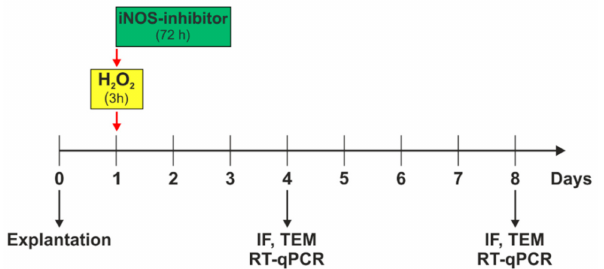
Figure 1. Experimental setup. Porcine retinas were cultivated for four and eight days. Oxidative stress was induced by 300 µ M H 2 O 2 on day one, for three hours. Simultaneously to the stressor, the iNOS-inhibitor treatment was applied and remained on retinal explants for 72 h. On day four, immunofluorescence (IF), transmission electron microscopy (TEM), and quantitative real-time PCR (RT-qPCR) analyses were performed. At day eight, IF, TEM, and RT-qPCR was